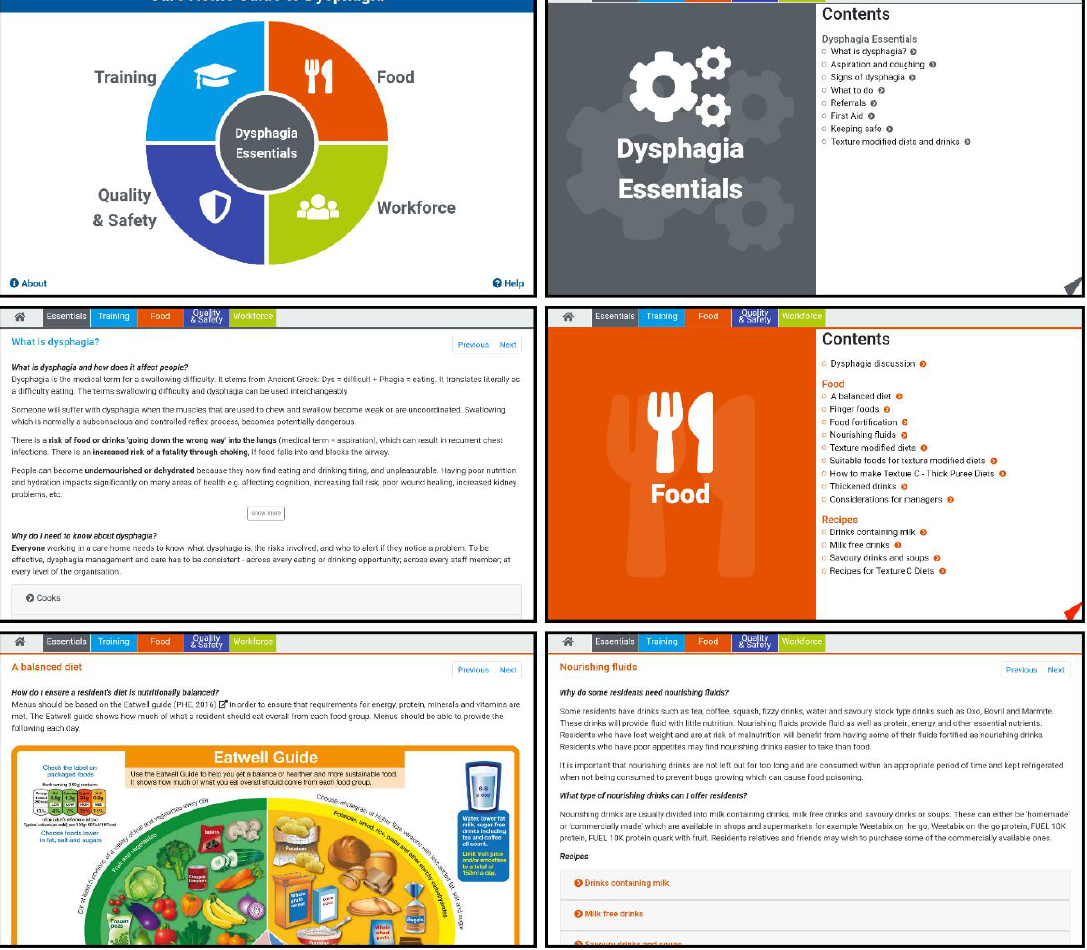
Figure 1. Screenshots of the dysphagia guide.